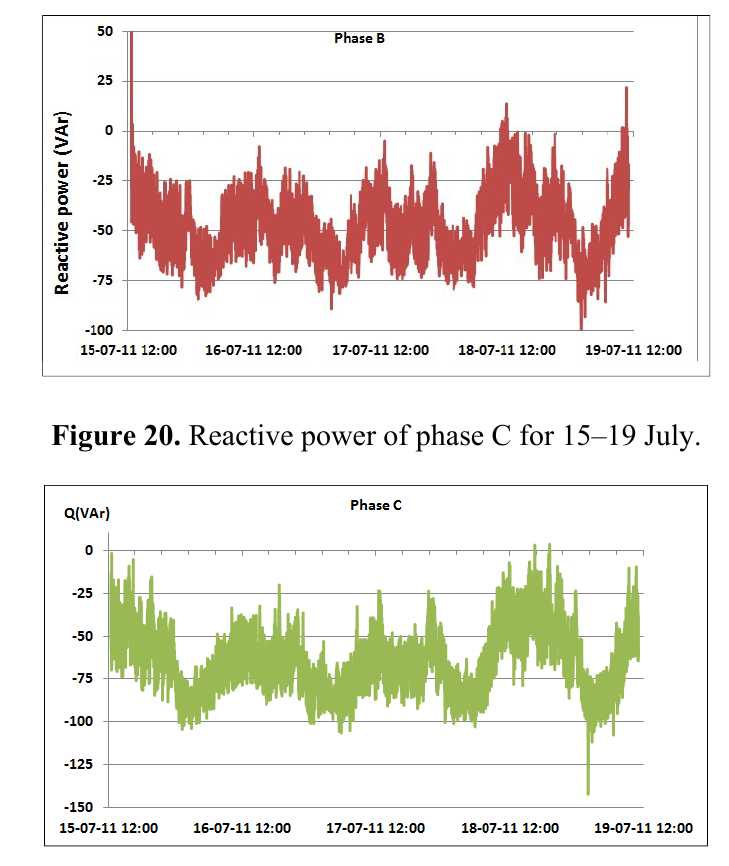
Figure 19. Reactive power of phase B for 15–19 July.